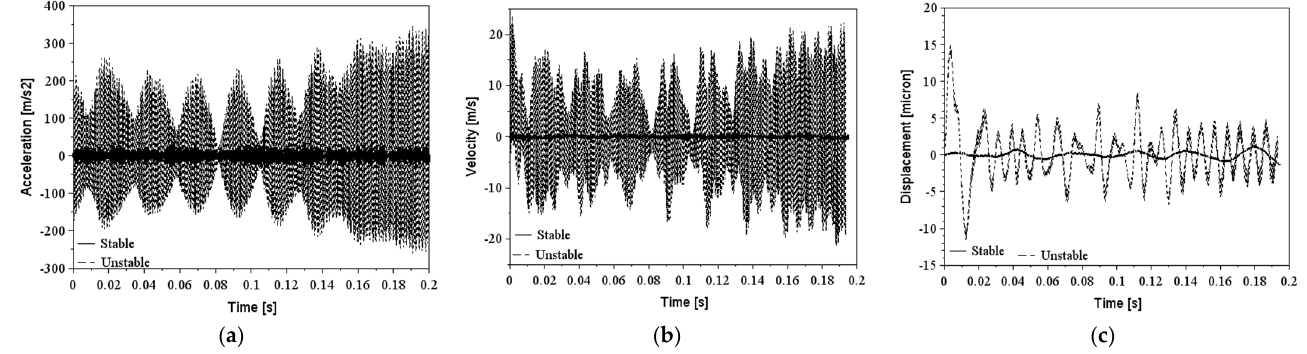
Figure 12. Excitation signals in stable TSC = 21.43 mm − 1 conditions with a TMD boring bar: ( a ) acceleration; ( b ) velocity; ( c ) displacement amplitudes.